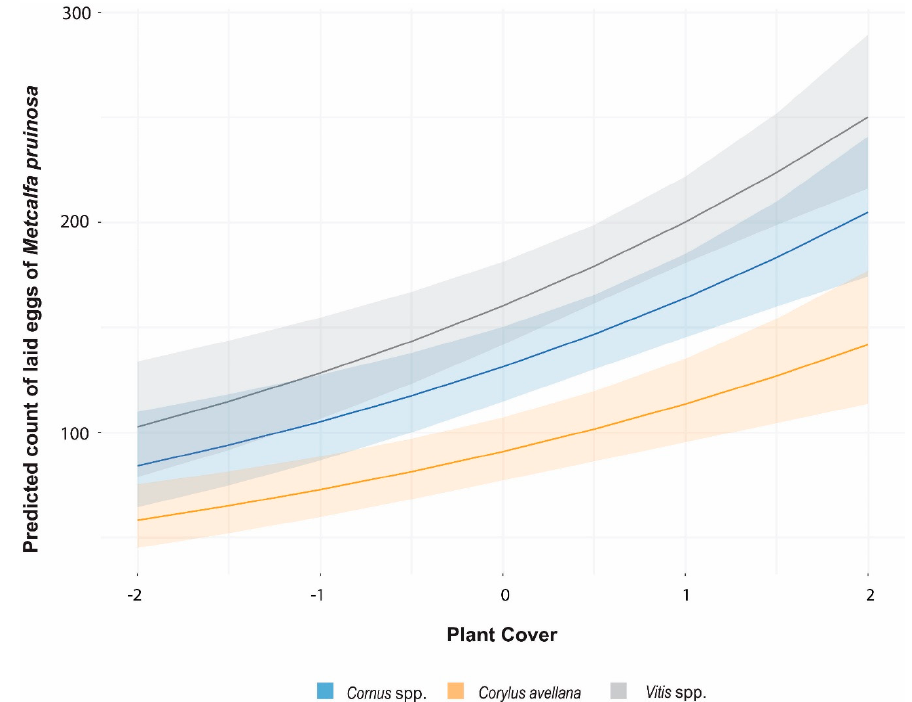
Figure 3. Curves of Metcalfa pruinosa oviposition on three Plant Species as a function of the standardized variable Plant Cover. Lines represent the Poisson negative binomial fit, shading represents the 95% confidence interval. The oviposition rate increased with Plant cover but differently according to the Plant Species. Insects 2020 , 11 , x FOR PEER REVIEW